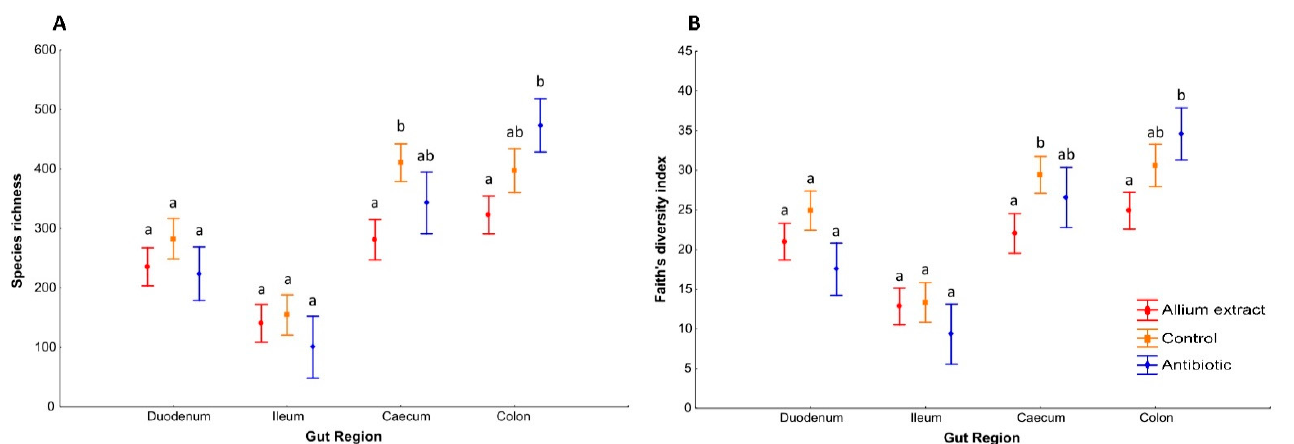
Figure 2. Alpha diversity by gut region. Average ± standard error of the mean of the bacterial species richness ( A ) and Faith’s diversity index ( B ) of weaned piglets in different gut regions. Bars with different letter within the same gut region denote significant differences in treatment (LSD Posthoc test; p < 0.05).